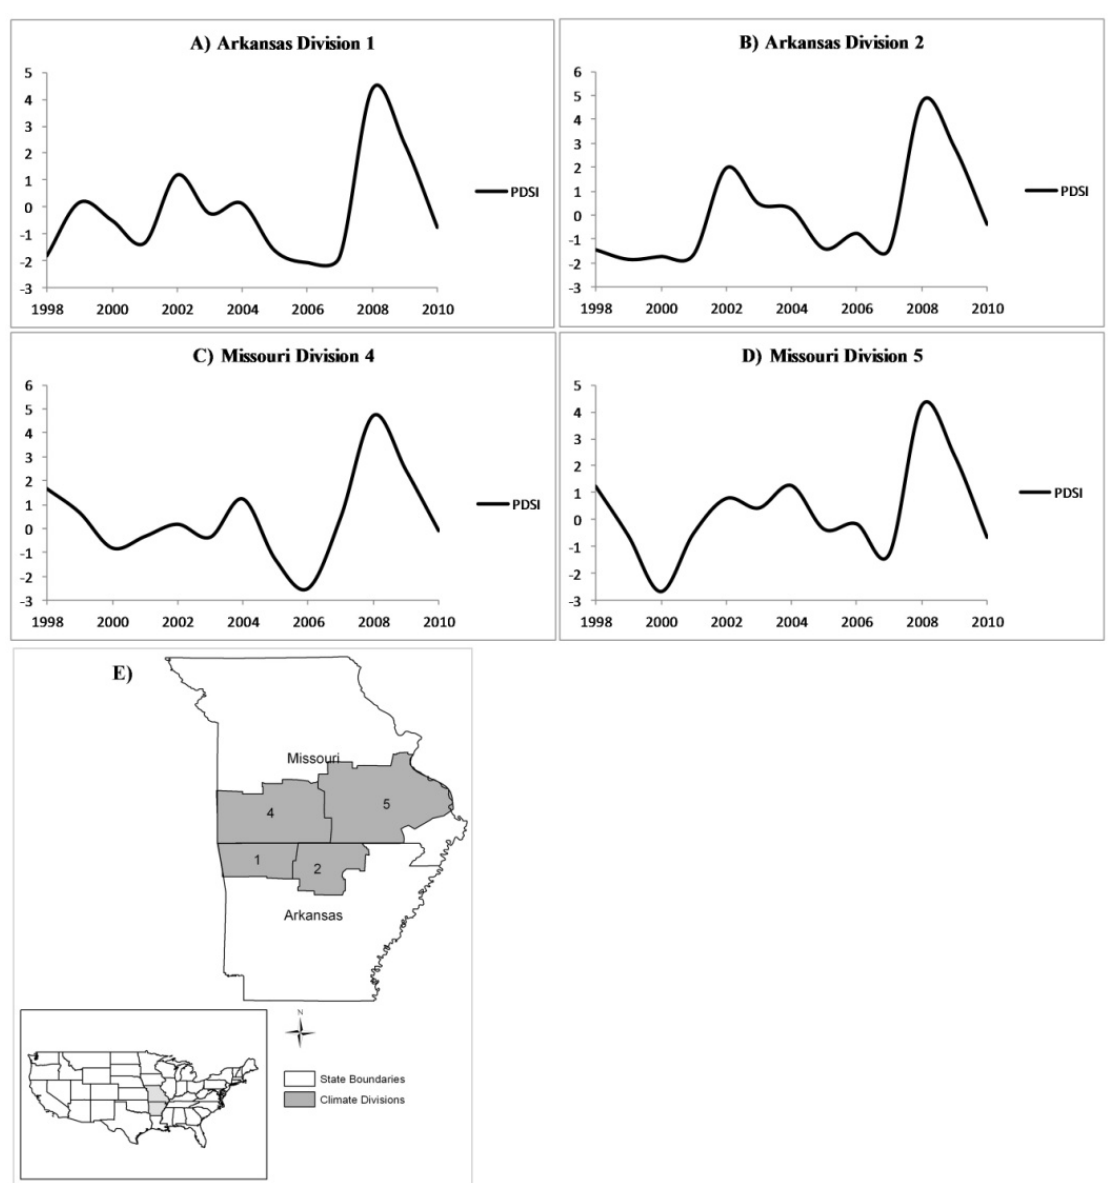
Figure 6. Annual growing-season PDSI for the years 1998–2010 for ( A ) Arkansas climate division 1; ( B ) Arkansas climate division 2; ( C ) Missouri climate division 4; and ( D ) Missouri climate division 5. A map depicting the locations of the four climate